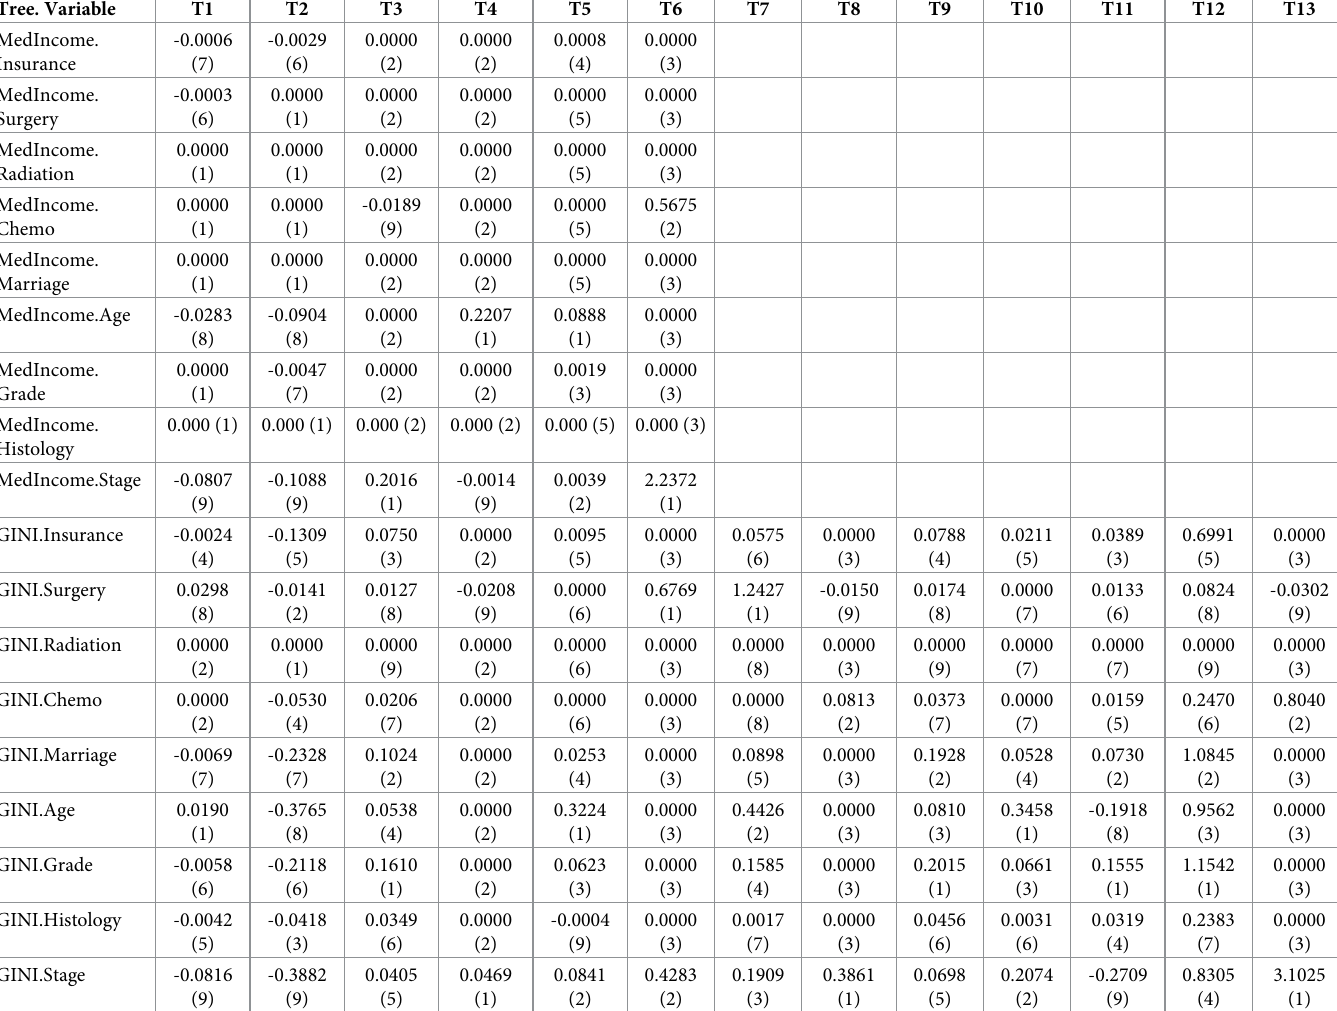
Table 6. Local variable importance measure for the GINI and MedIncome HPRISM trees. T1, ... , T13 indicate terminal node number. Tree.